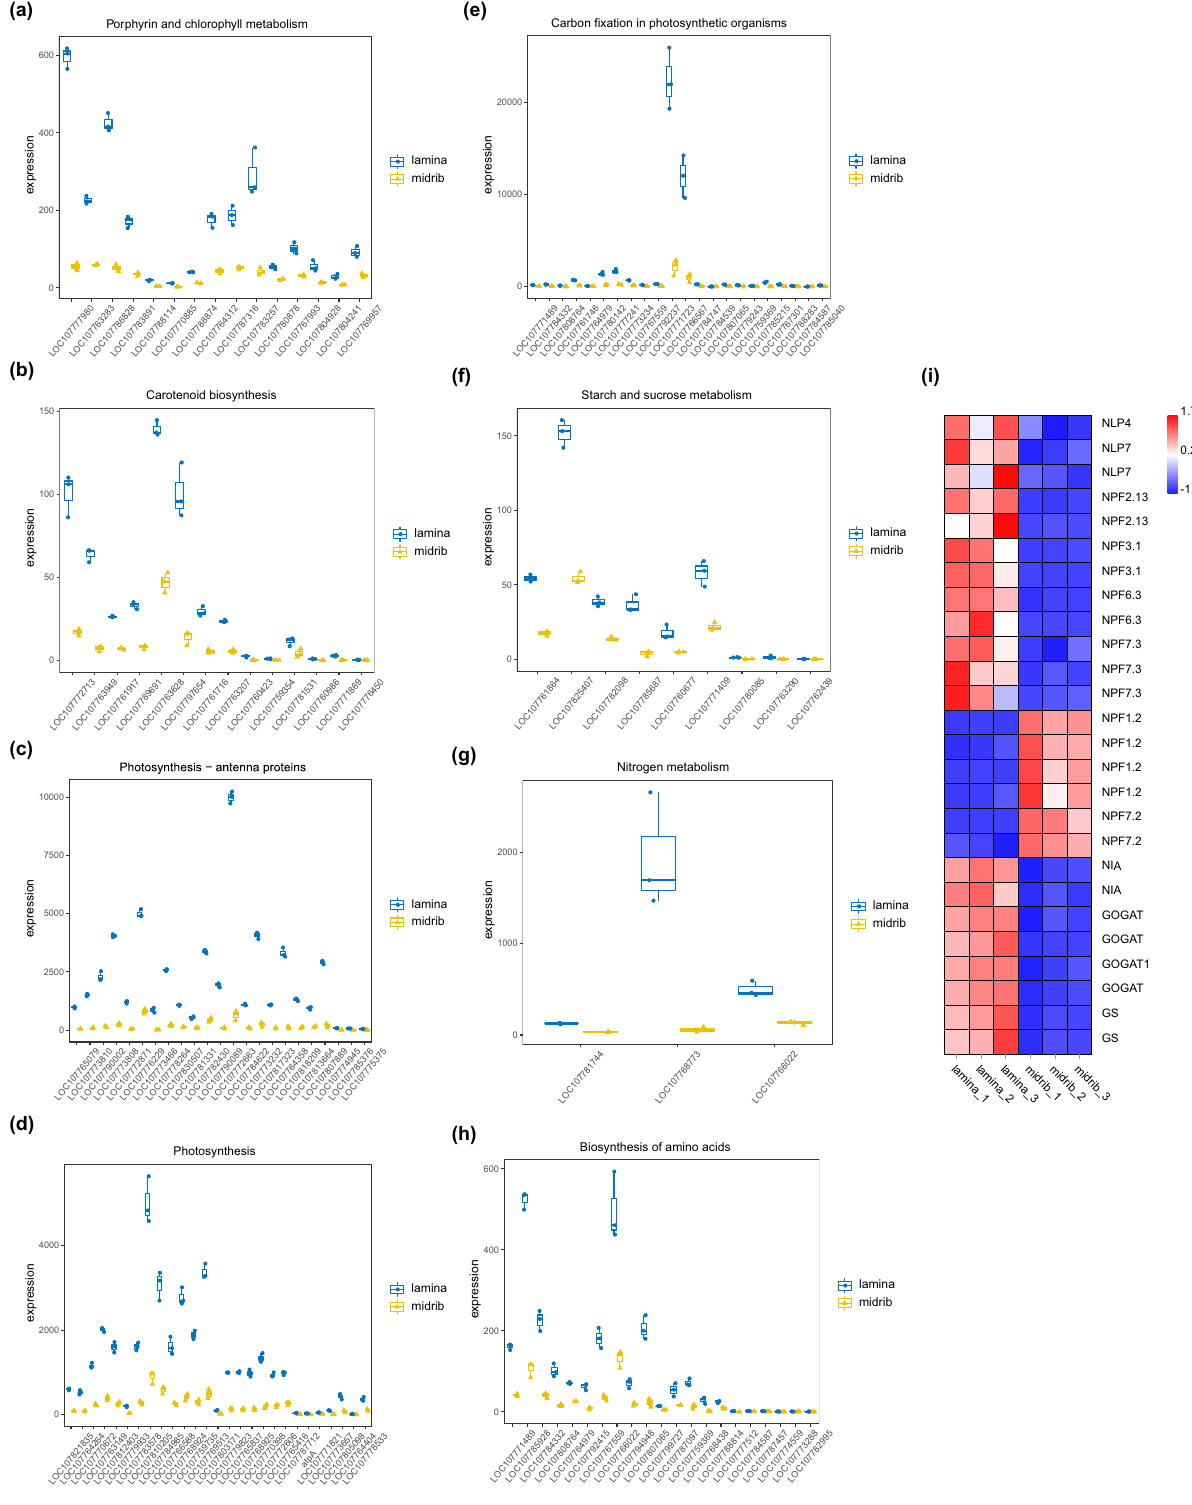
Figure 4. ( a ) Porphyrin and chlorophyll metabolism; ( b ) carotenoid biosynthesis; ( c ) photosynthesis- antenna proteins; ( d ) photosynthesis; ( e ) carbon fixation in photosynthetic organisms; ( f ) starch and sucrose metabolism; ( g ) nitrogen metabolism; ( h ) biosynthesis of amino acids; ( i ) expression of genes involved in nitrate response, transport and assimilation. Box-whisker plot represents dispersity of minimum, first quartile, median, third quartile in genes expression level of treatments. Y-axis represents expression level. The columns represent six samples. The name of gene is on the right side, the up-or down-regulated proteins are indicated in red and green, respectively. The intensity of the colors increases with increasing expression level as noted on the color bar on the right